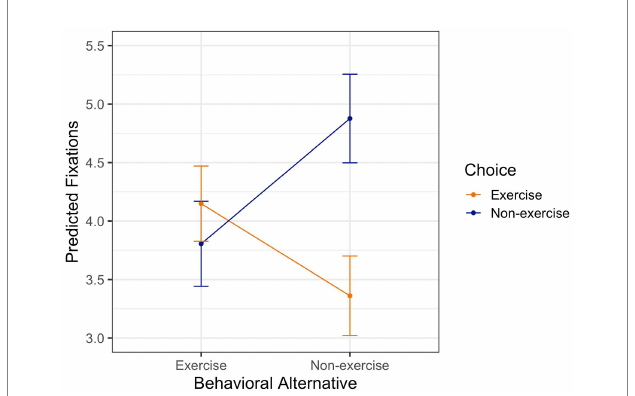
FIGURE 2 Predicting fixations on the exercise and the non-exercise behavioral alternative with choice behavior. The orange line shows the model- predicted fixations when exercise was chosen. The blue line shows the model predicted fixations when non-exercise was